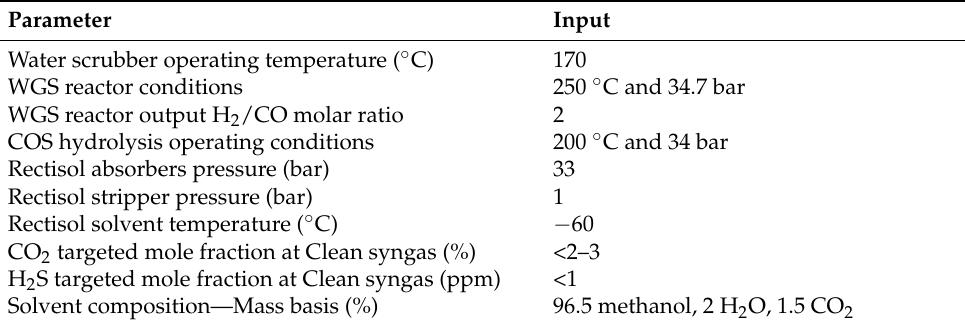
Table 5. Gas cleaning unit process